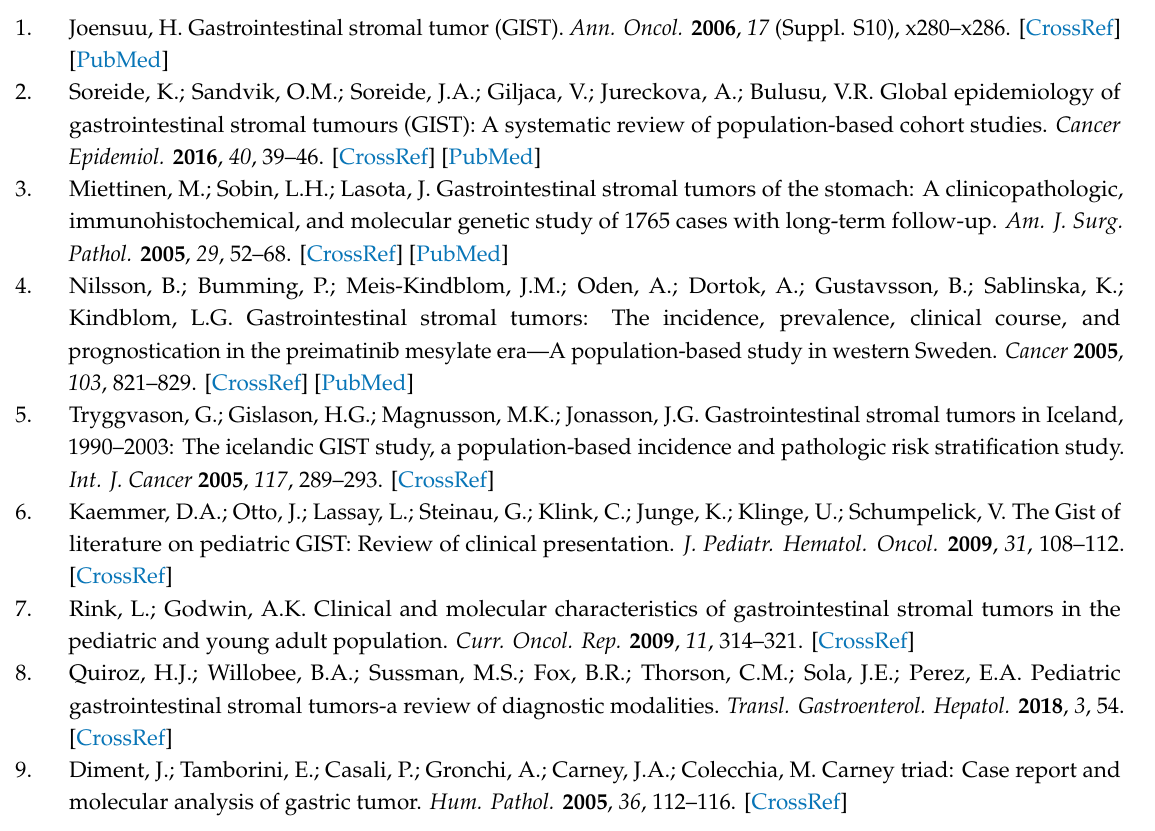
Table S1: Adolescents and young adults (AYA) age-related GIST data in the existing